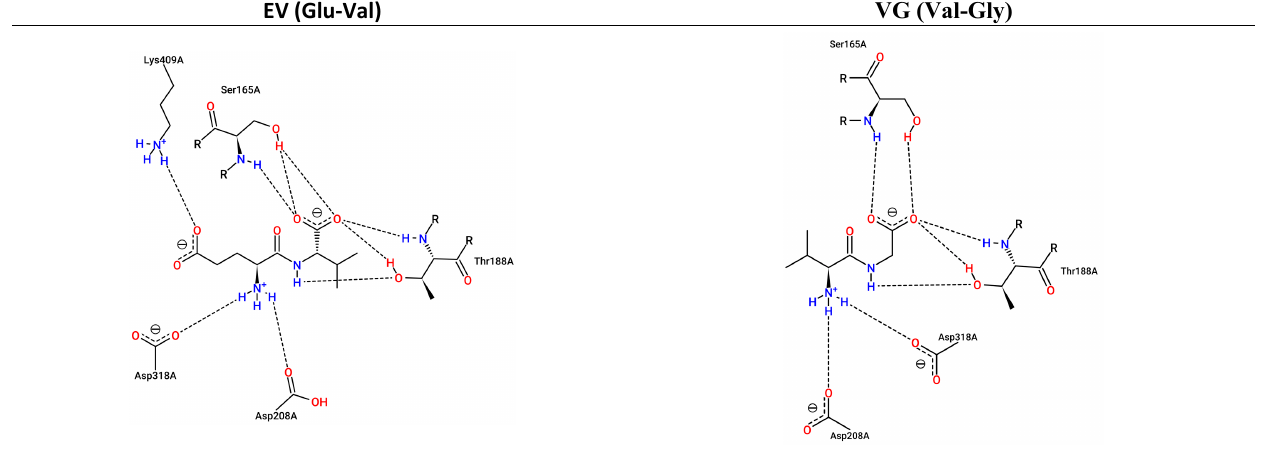
Figure 4. Two-dimensional representation of protein–ligand interactions between Homo sapiens open–open conformation of mGluR1 (PDB ID: 3KS9) and Glu (PubChem ID: 33032), AH (PubChem ID: 9837455), DA (PubChem ID: 5491963), DG (PubChem ID: 151148), EE (PubChem ID: 439500), ES (PubChem ID: 6995653), EV (PubChem ID: 6992567), VG (PubChem ID: 6993111). H bonds are shown as dashed lines, hydrophobic contacts are represented by green splines; the corresponding pocket residues are also shown in the same color. Diagrams obtained from the ProteinsPlus PoseView tool, from which E amino acid was predicted to interact with Tyr74, Arg78, Ser186, and Lys409; AH, with Ser165, Thr188, Asp208, Asp318; DA, with Ser165, Thr188, Asp318, and Lys409; DG, with Ser165, Asp208, Asp318 and Lys409; EE, with Ser165, Thr188, Asp208, and Lys409; ES, with Ser165, Thr188 and Lys409; EV, with Ser165, Thr188, Asp208, Asp318, and Lys409; and VG, with Ser165, Thr188, Asp208, and Asp318. H-bonds were estimated by PoseView to be stabilized in all cases.